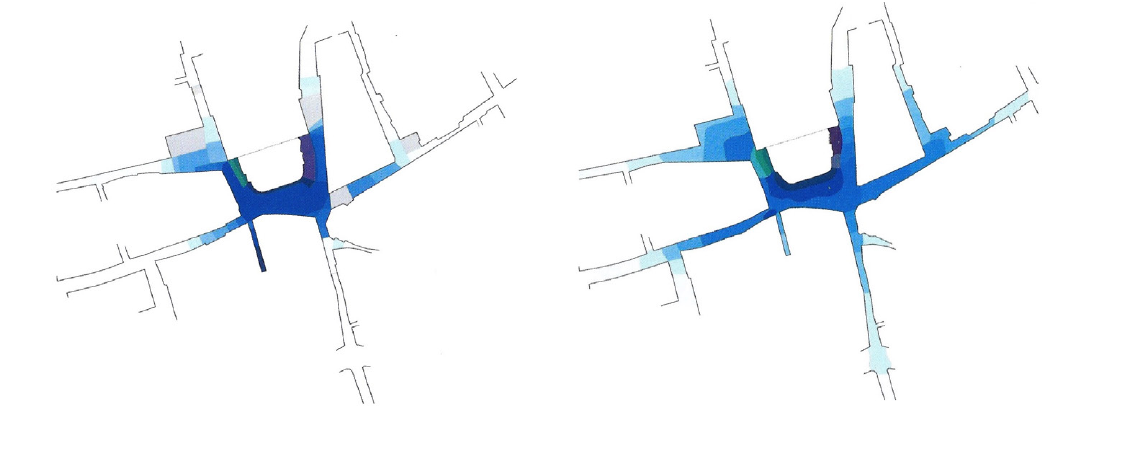
Figure 9: Piazza Fontana di Trevi visualization of the perceptive survey. ( A ) day survey, ( B ) night survey. Color and its shades represent dif- ferent extent of recognizability of the sound of the fountain. Notice the affected area is much larger than the square itself. (reproduced from [36] with permission by